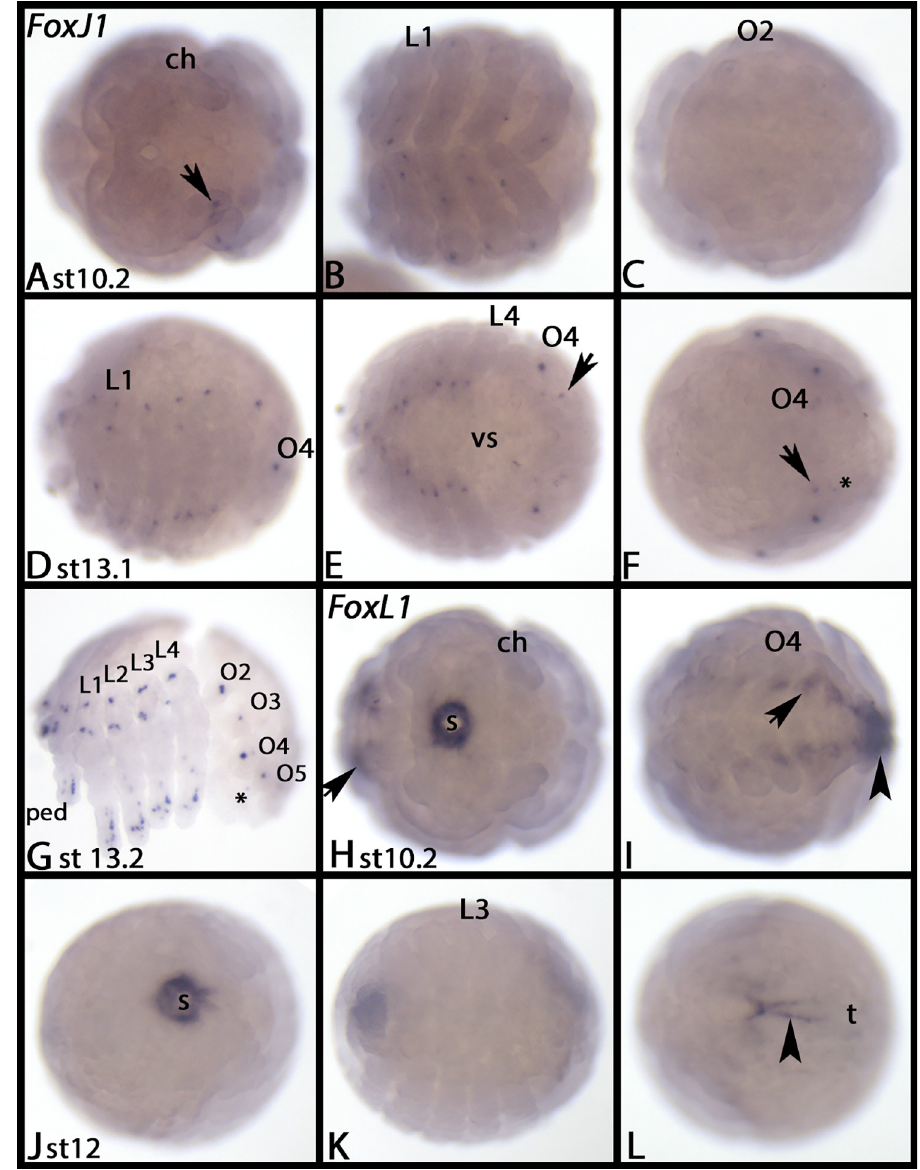
Fig 13. Expression of Parasteatoda FoxJ1 (A-G) and FoxL1 (H-L). In all panels, anterior is to the left, ventral views, except panels D, lateral view, F, dorsal view and G, lateral view. Arrow in panel A marks expression in the chelicera. Arrows in panels E and F point to expression in the spinnerets on opisthosomal segment 5. Asterisks in panels F and G mark a second dot of expression in O5. Arrows in panels H and I point to expression ventral to the base of the limbs. Arrowheads in panels I and L point to expression in the tail region. Abbreviations in Table 2. DAPI staining of the embryos shown in this figure are presented in S15